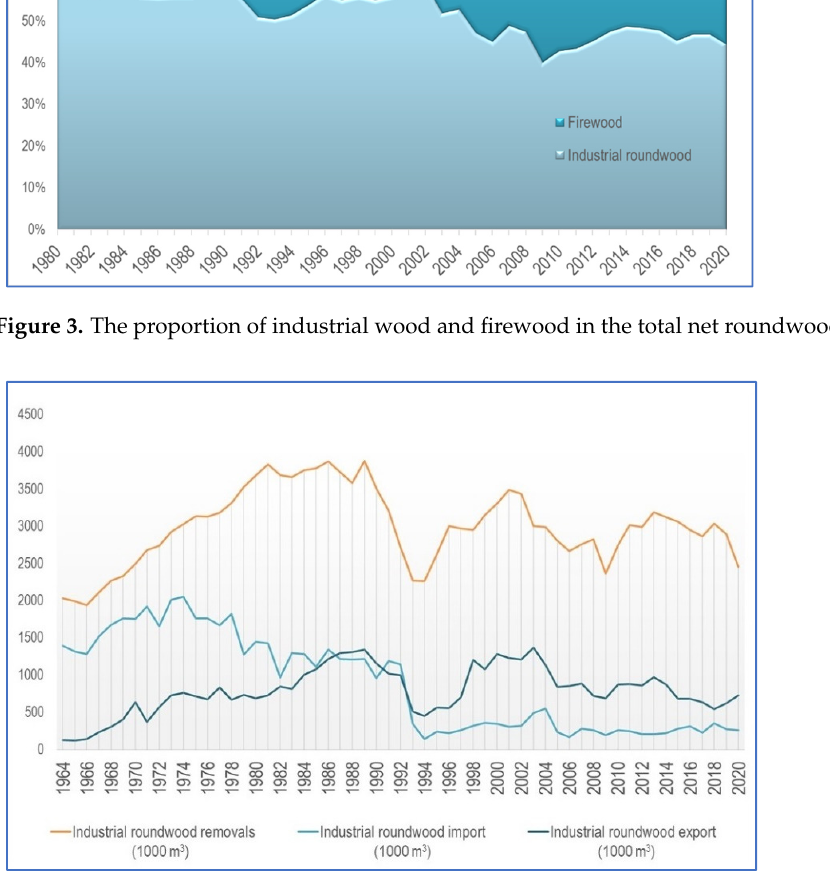
Figure 4. Industrial roundwood removal, import, and export in time period of 1964–2020.